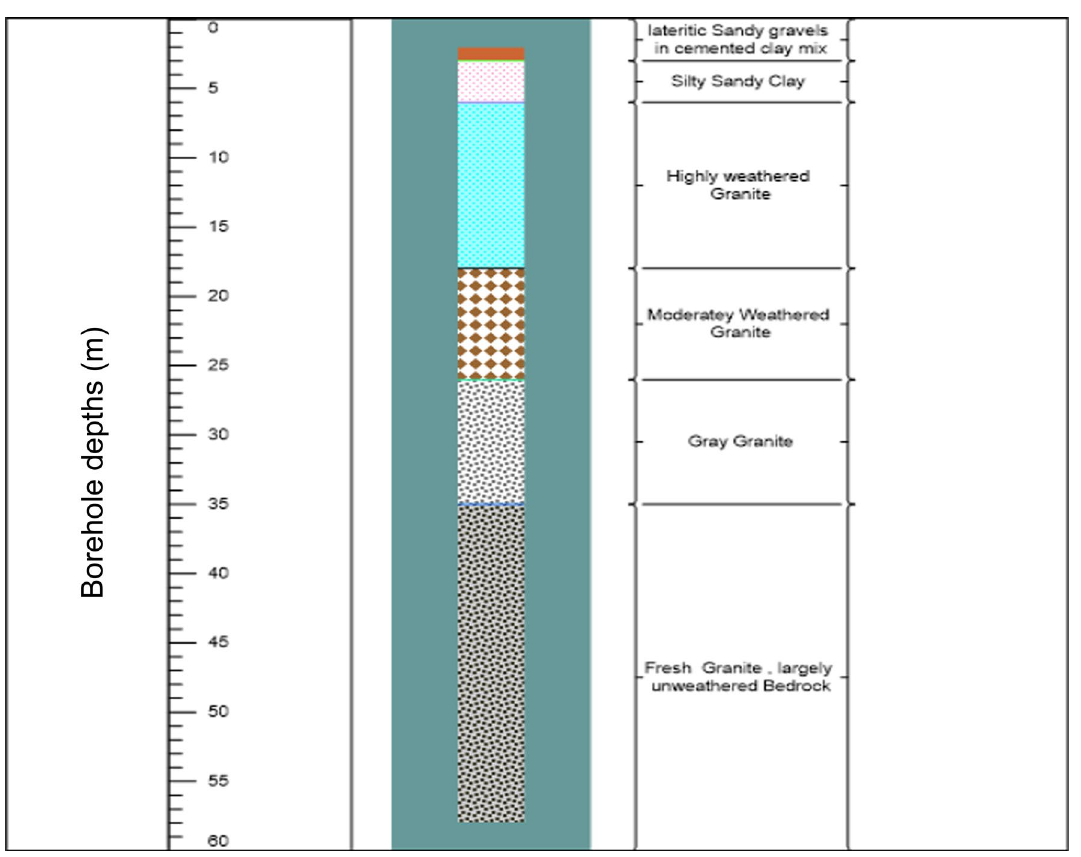
Fig. 3 Hydrostratigraphy of boreholes in the study